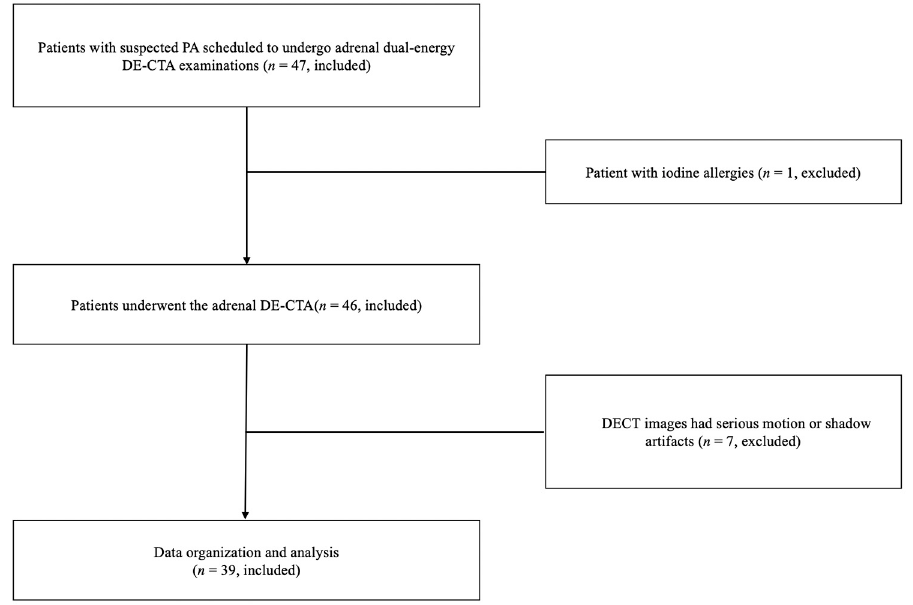
Figure 1. Flow diagram for subject selection. PA, primary aldosteronism; DE-CTA, dual energy- computed tomography angiography; DECT, dual-energy computed tomography.